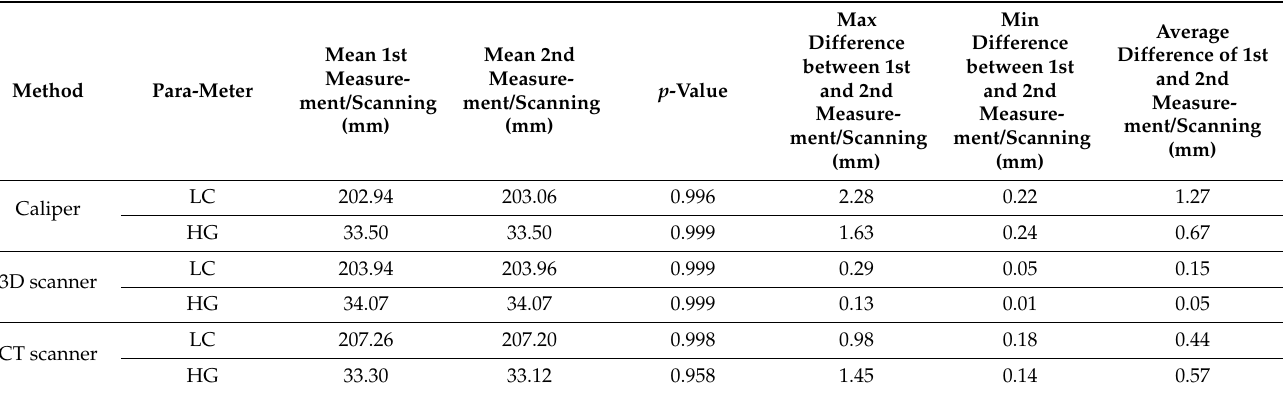
Table 5. Differences in the accuracy of the methods used for distance measuring of all wild boar